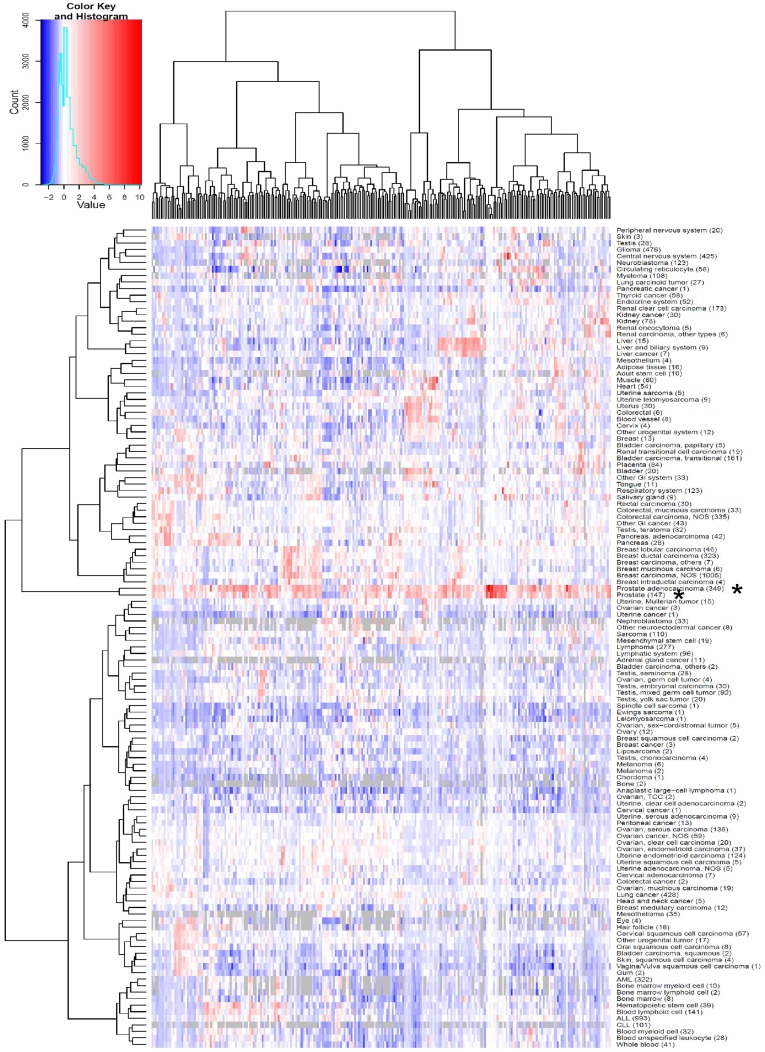
RNAi library target gene expression in silico.A heatmap presentation of the mean gene expression levels of the 295 genes (x-axis) selected for further RNAi exploration in all of the tissues (healthy and malignant) present in GeneSapiens database (y-axis). The position of prostate cancer (upper asterisk) and healthy prostate (lower asterisk) have been indicated. The colour illustrates the level of expression in different tissues, and grey missing values. The heatmap is drawn based on unsupervised hierarchical clustering.